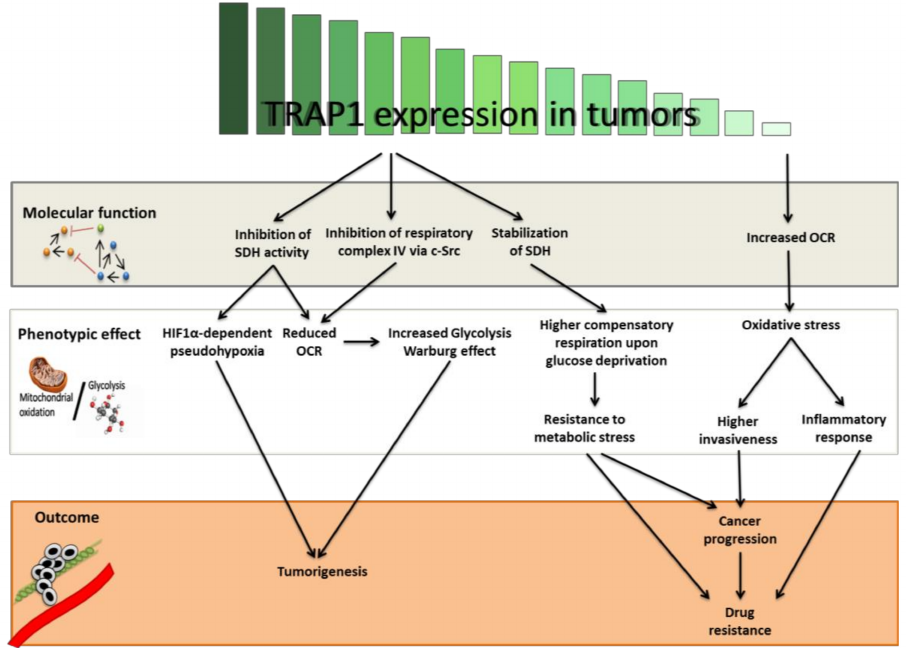
Figure 1. Hierarchical effects of Tumor Necrosis Factor Receptor-associated Protein 1 (TRAP1) expression levels on tumor development and progression through the regulation of energetic metabolism. TRAP1 binds respiratory complexes in the mitochondrial matrix and regulates their activity, either directly or indirectly via c-Src (grey box). This regulation alternatively leads to (i) a switch toward a more glycolytic (Warburg) phenotype, (ii) an enhanced ability to handle metabolic stress through the use of spare respiratory capacity and (iii) increased oxidative stress (white box). As a result, tumors with high glycolytic metabolism or limiting nutrient availability may gain the advantage of a high TRAP1 expression. Conversely, tumors mostly relying on oxidative metabolism may counter-select TRAP1 expression for progression and development of resistance and metastases (orange box). OCR: oxygen consumption rate; SDH: Succinate dehydrogenase; c-Src: SRC Proto-Oncogene; HIF1 α : Hypoxia Inducible Factor 1 Alpha